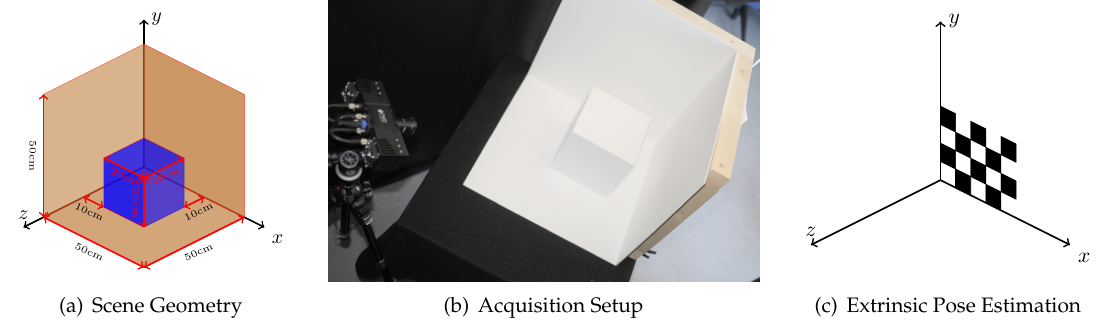
Figure 5. The geometry of our box scene (light brown) with the additional cube (blue) ( a ); a photo of the AMCW ToF measurement setup ( b ); and the positioning of the calibration pattern for ToF camera pose estimation ( c ).